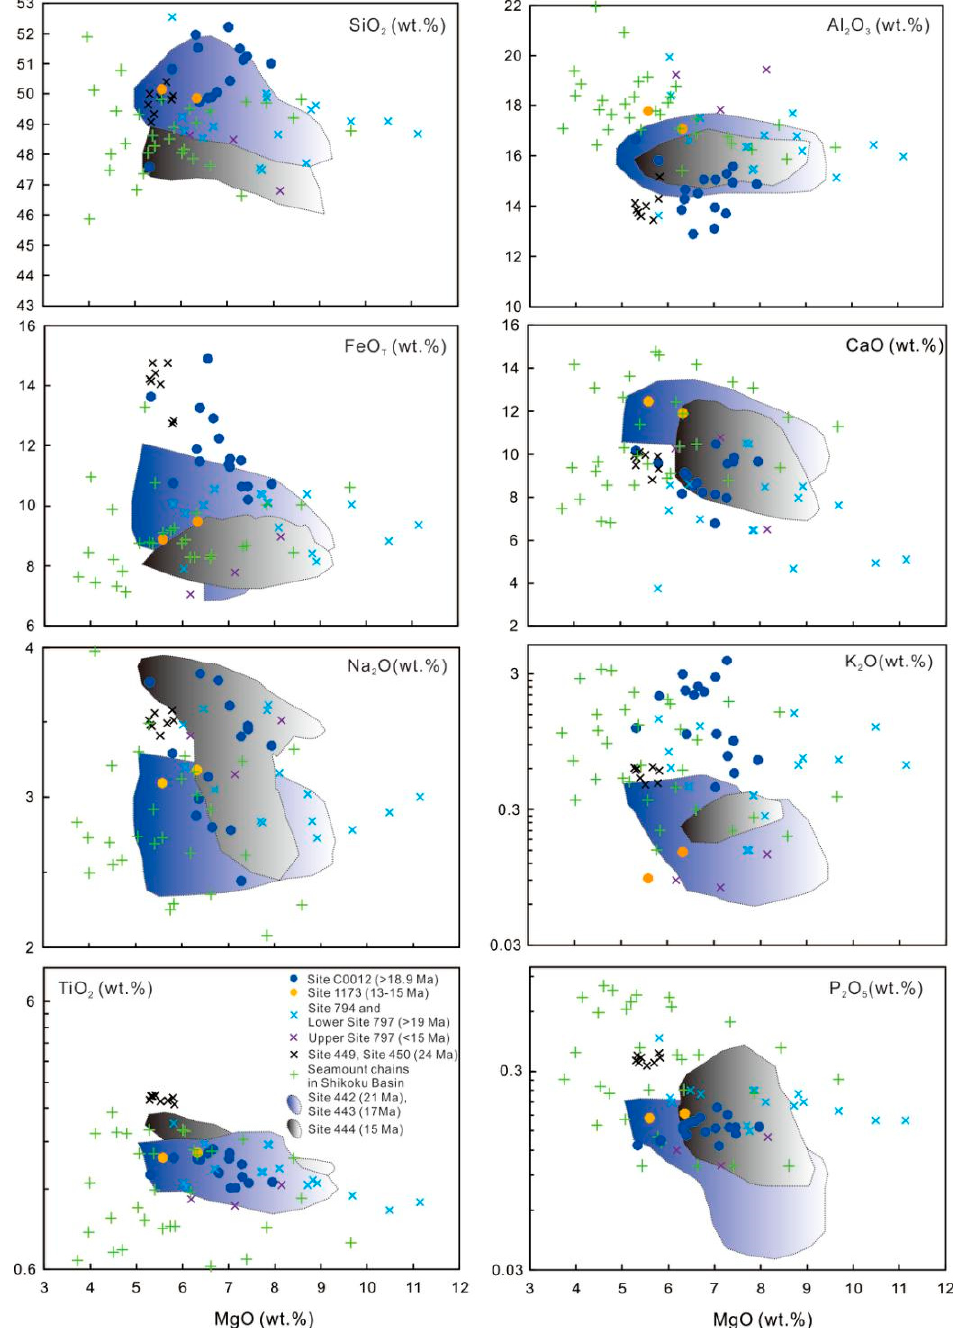
Figure 7. MgO versus major elements of Cenozoic volcanic rocks from the Shikoku Basin. The Site 442, 443, 444 data in the Shikoku Basin are from Reference [52–55]. Other data sources as for Figure 6.